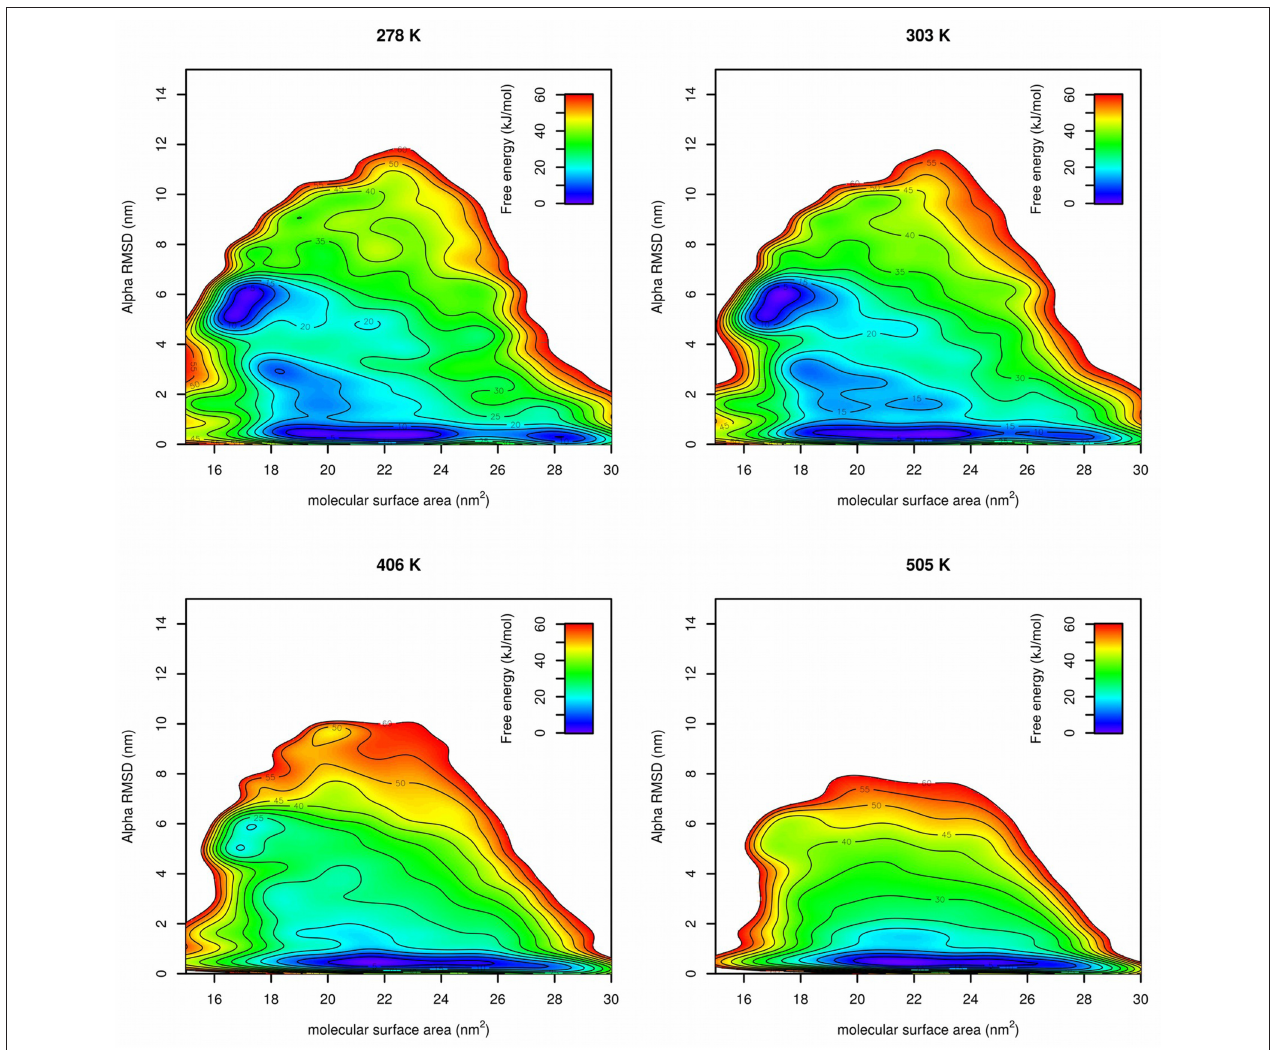
FIGURE 5 | Free energy surfaces of Trp-cage calculated by PT-METAD with SASA and Alpha RMSD collective variables at four selected